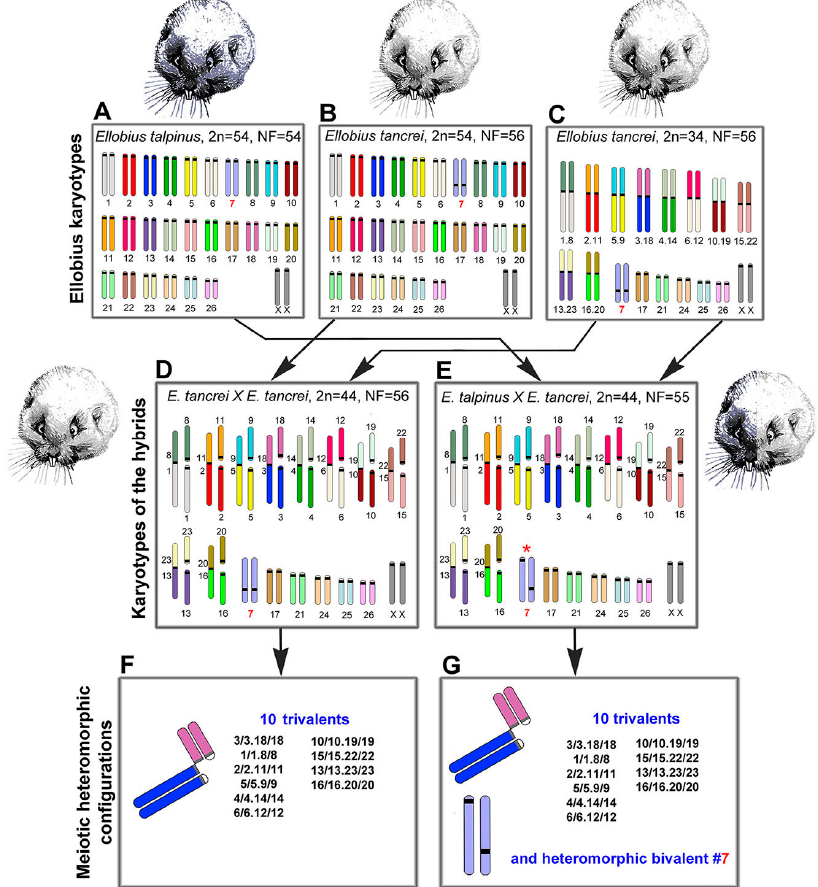
Figure 1. Scheme of the experimental hybridization of Ellobius species and hybrids. ( A – C ) Karyotypes for E talpinus , 2 n = 54, NF = 54 ( A ); E. tancrei , 2 n = 54, NF = 56 ( B ); and E. tancrei , 2 n = 34, NF = 56 ( C ). ( D , E ) F1 hybrid karyotypes for E. tancrei × E. tancrei , 2 n = 44, NF = 56 ( D ) and E. talpinus × E. tancrei , 2